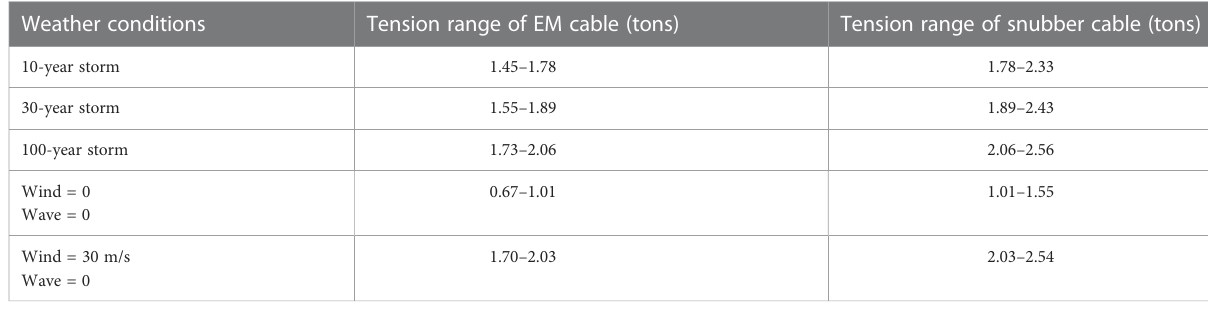
TABLE 8 Comparison of the mooring tension in a Nilspin EM cable with the snubber up for different weather conditions